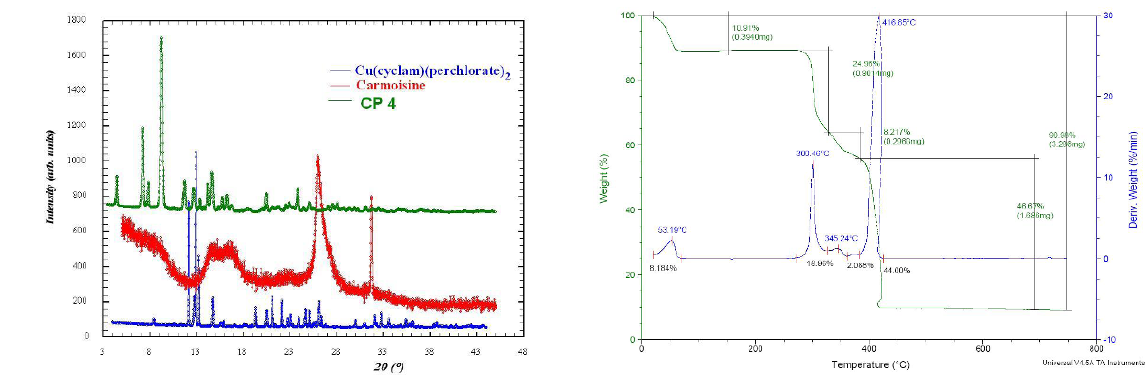
Figure 1. PXRD patterns for {[Cu II (cyclam)](carmoisine dianion) (H O) } ( 4 ) and for starting materials. 2 5 n